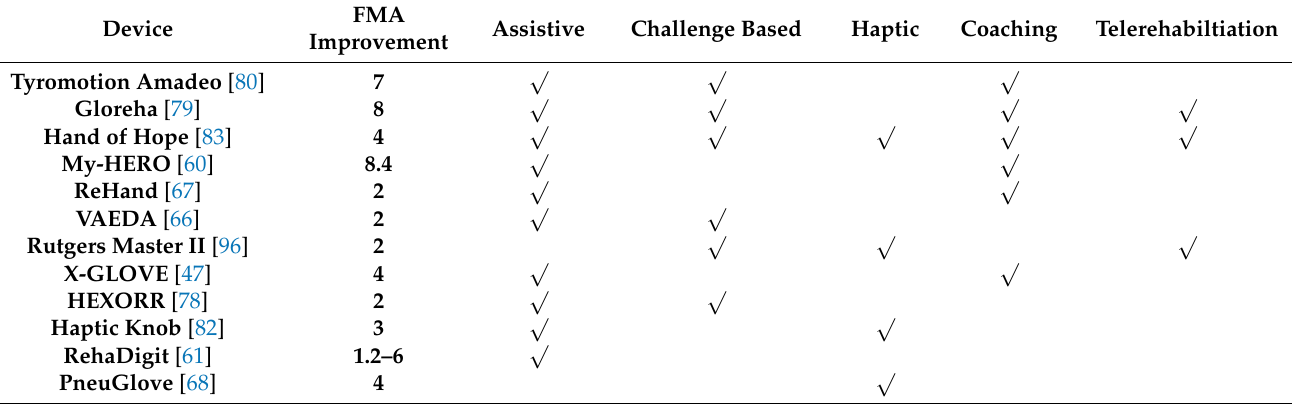
Table 8. Comparison of Rehabilitation Strategies and FMA score